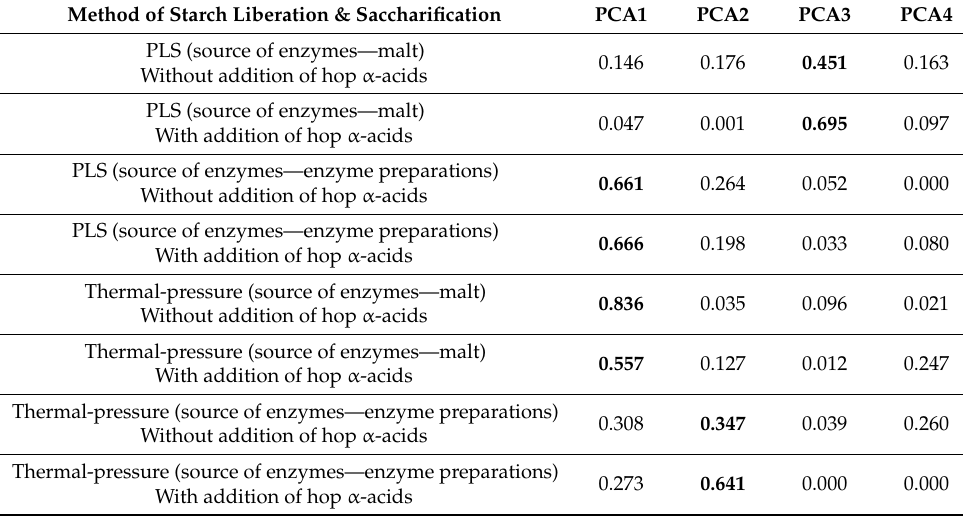
Table 11. Squared cosines of the